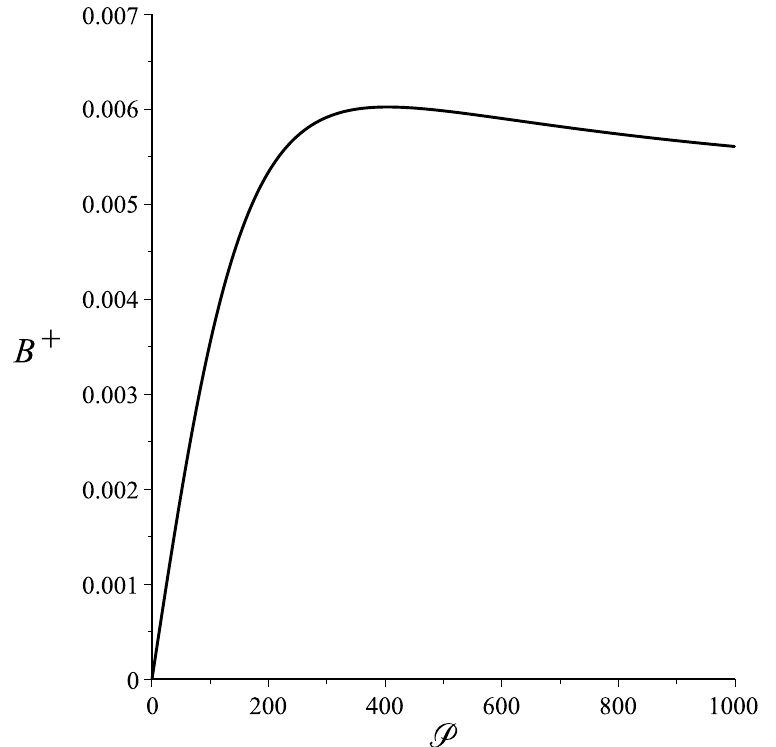
Figure 5 . The magnetic field, evaluated on the event horizon at the equator, as a function of the physical charge, for an extremal AdS 4 -Kerr-Newman magnetic black hole with L = 100 , a = 50 . (Units are Planck